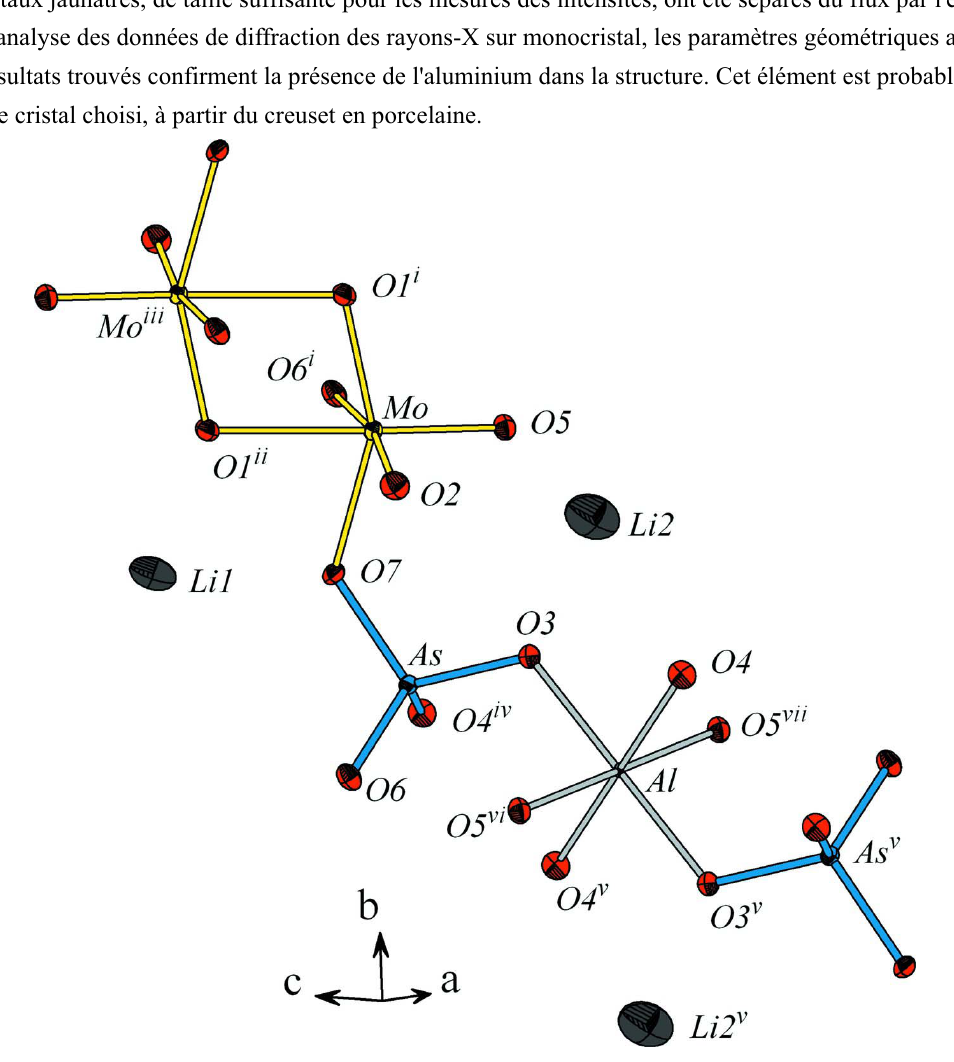
Unité structurale dans Li (i) x , y + 1, z ; (ii) - x + 1, - y + 1, - z + 1; (iii) - x + 1, - y + 2, - z + 1; (iv) x - 1, y , z ; (v) - x + 1, - y , - z ; (vi) x , y - 1, z ; (vii) - x +